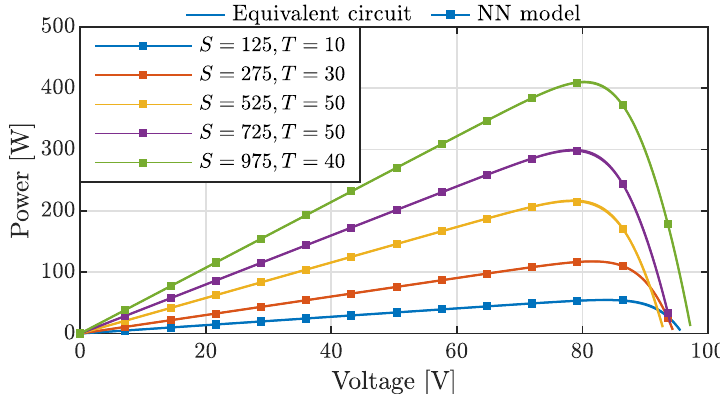
Figure 6. Comparison between P - V curves of PV module generated by the equivalent circuit and NN model of the photovoltaic.